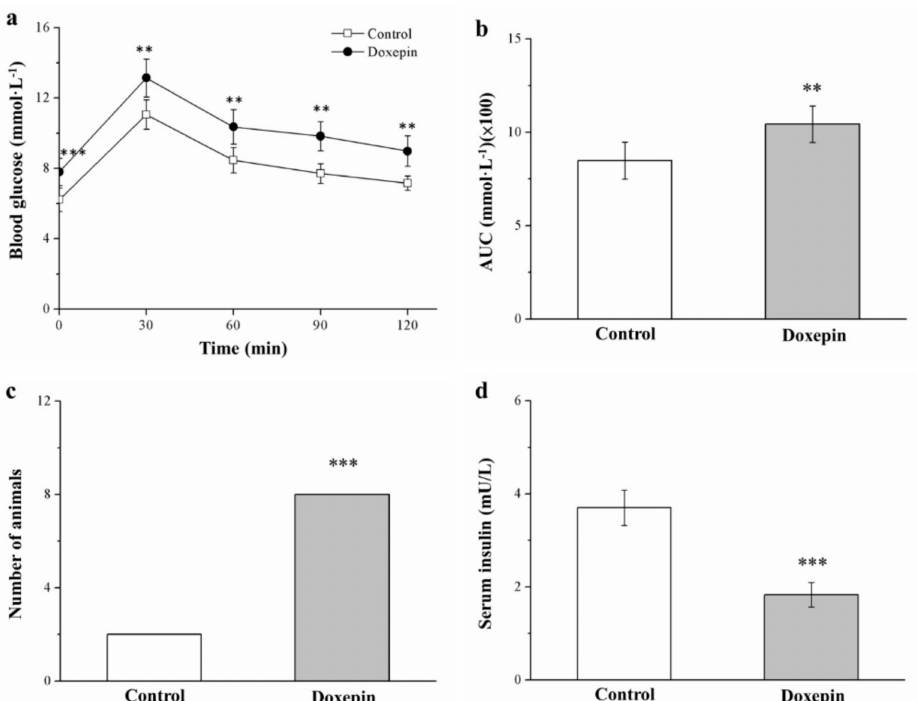
Figure 6. ( a ) IPGTT curve. ( b ) AUC during the 120 min following glucose injection, ( c ) glucose intolerance criterion (Fisher’s exact test), and ( d ) serum insulin levels in the controls and doxepin- treated mice over 56 treatment days. All values represent means ± standard deviations ( n = 10 for all groups). ** p < 0.01 and *** p < 0.001 indicate high and very high statistical significance,